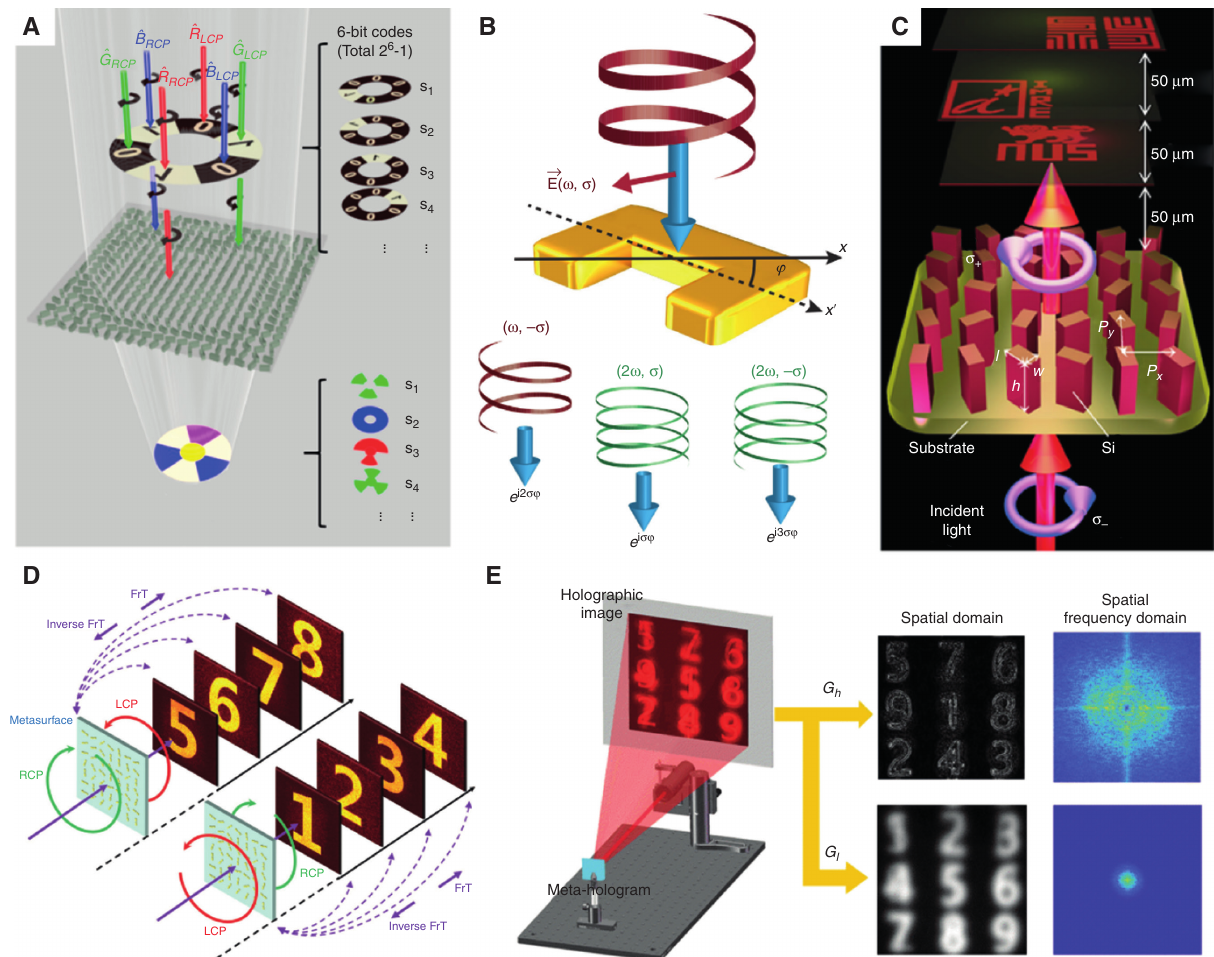
Figure 14: “Many-to-many” scheme for information multiplexing in terms of the transmission and observation ends. (A) Multiplexed metasurfaces by taking wavelength and helicity as design degrees of freedom [105]. (B) Multiplexed metasurfaces enabled with nonlinear effect [106]. (C and D) Multiplexed Fresnel holograms by assigning different working distances [107, 108]. (E) Metasurfaces with spatial frequency multiplexing [109]. Reprint permission obtained from